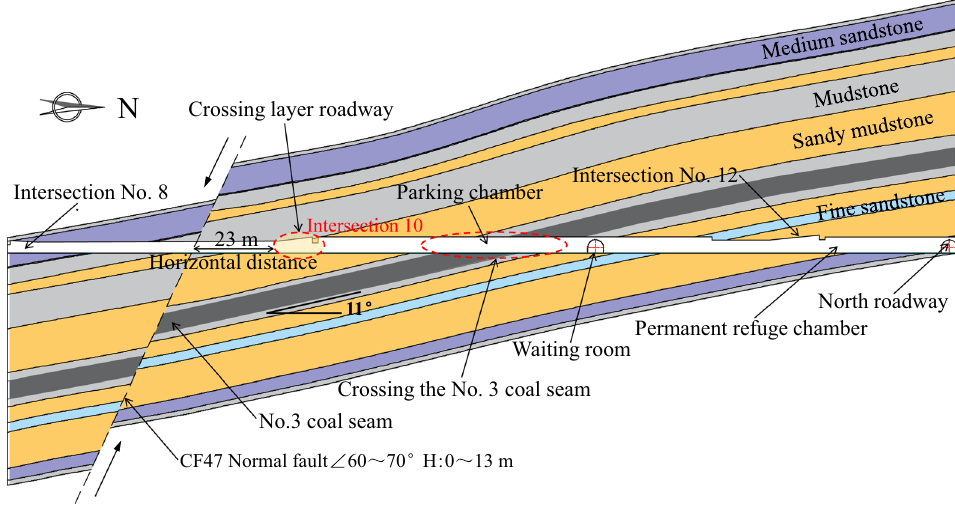
Intersection No. 8